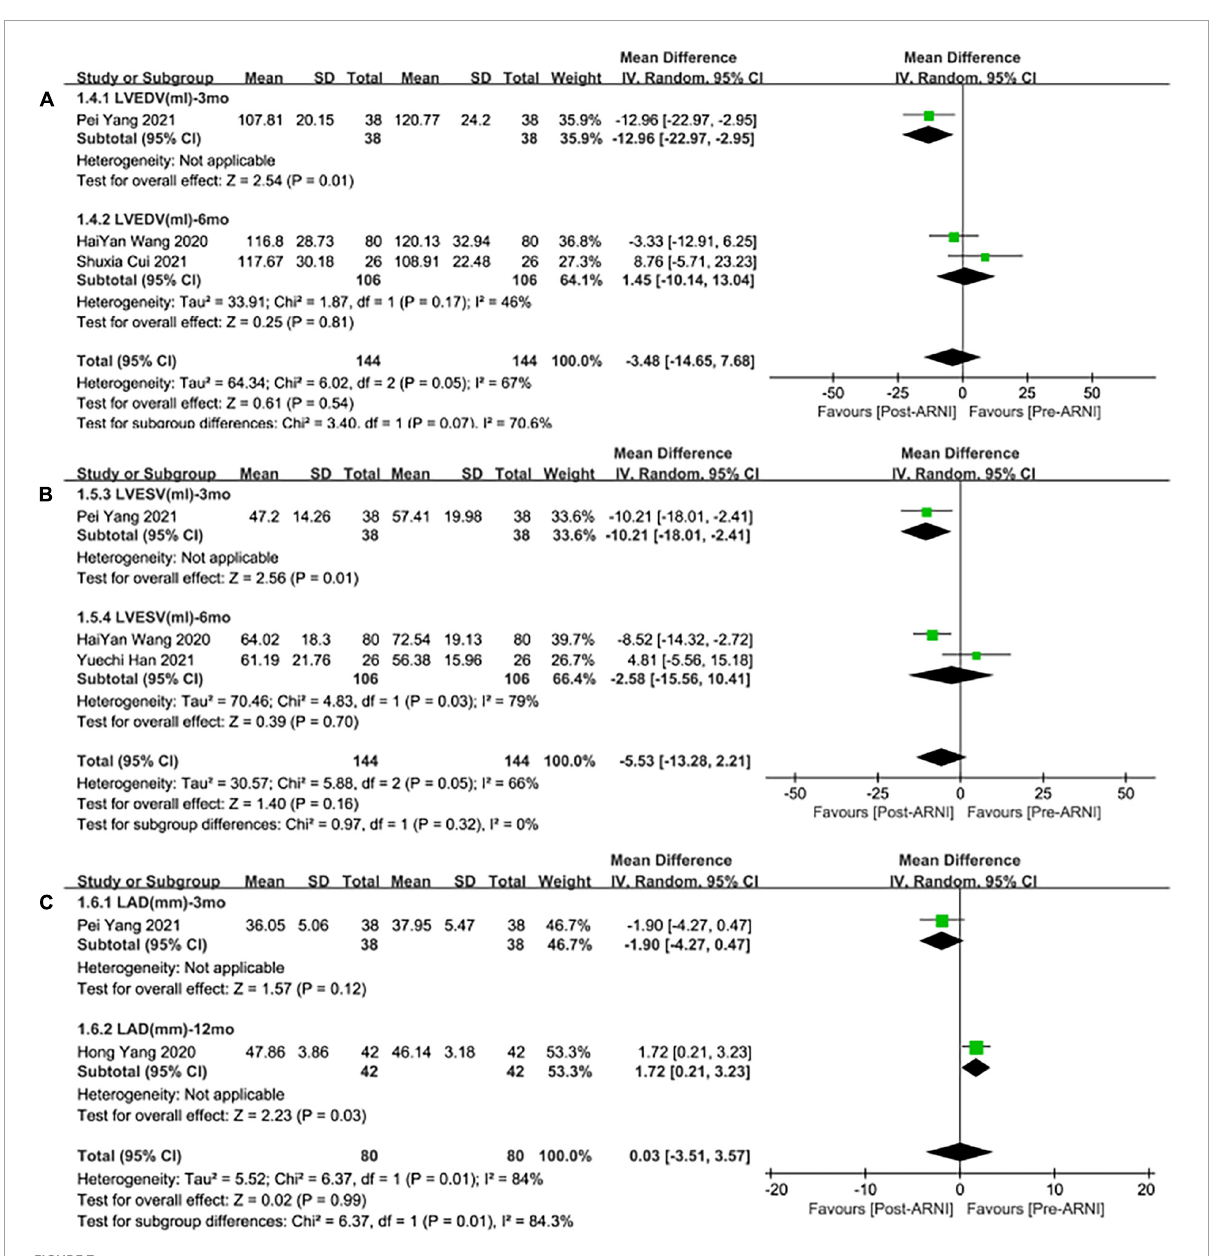
FIGURE7 Subgroup analysis of ARNI effects on CRR indices according to follow-up periods (2). (A) Subgroup analysis on left ventricular end-diastolic volume, (B) subgroup analysis on left ventricular end-systolic volume, and (C) subgroup analysis on left atrial dimension.